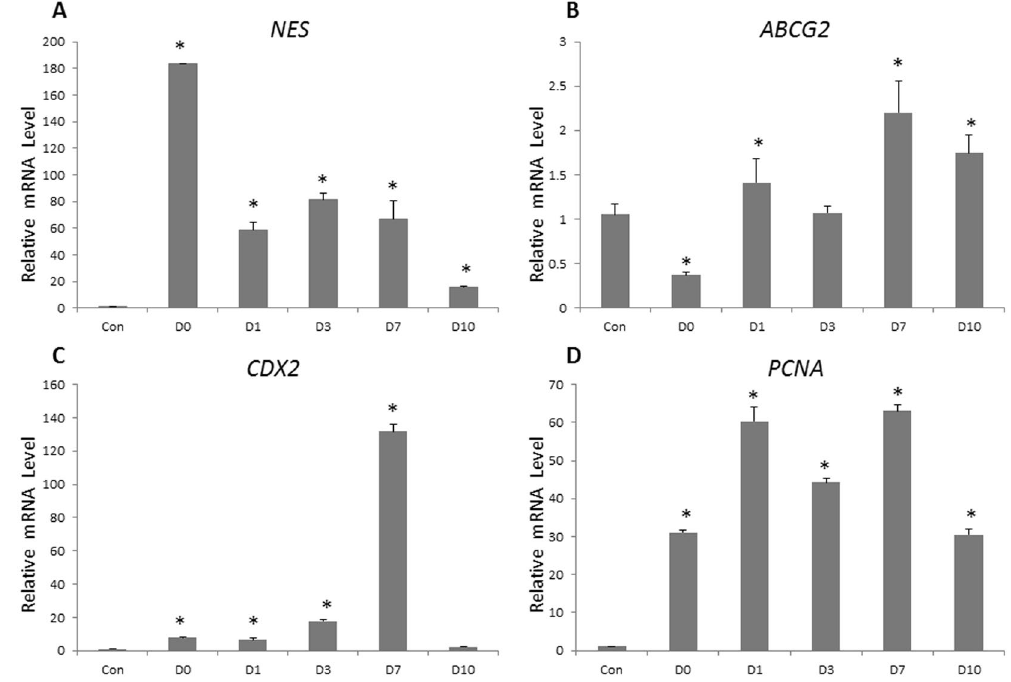
Figure 5. Epithelial proliferation-associated gene expression levels change in lacrimal gland tissues after duct ligation-induced injury. Real-time quantitative reverse transcription PCR (RT-qPCR) showed that NES ( A ), ABCG2 ( B ), CDX2 ( C ), and PCNA ( D ) gene expression dramatically increased after the main excretory duct ligation and reopening process ( * P <